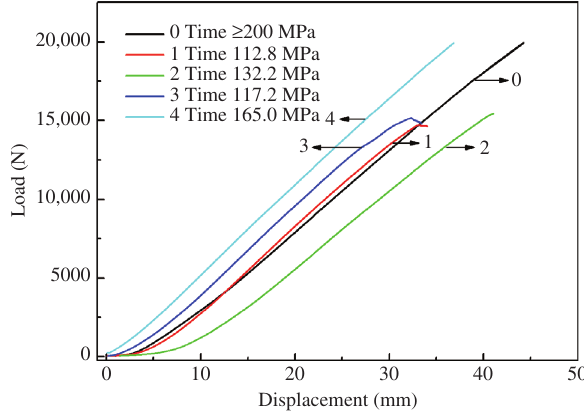
Figure 10 The compression load-displacement curves of different samples.